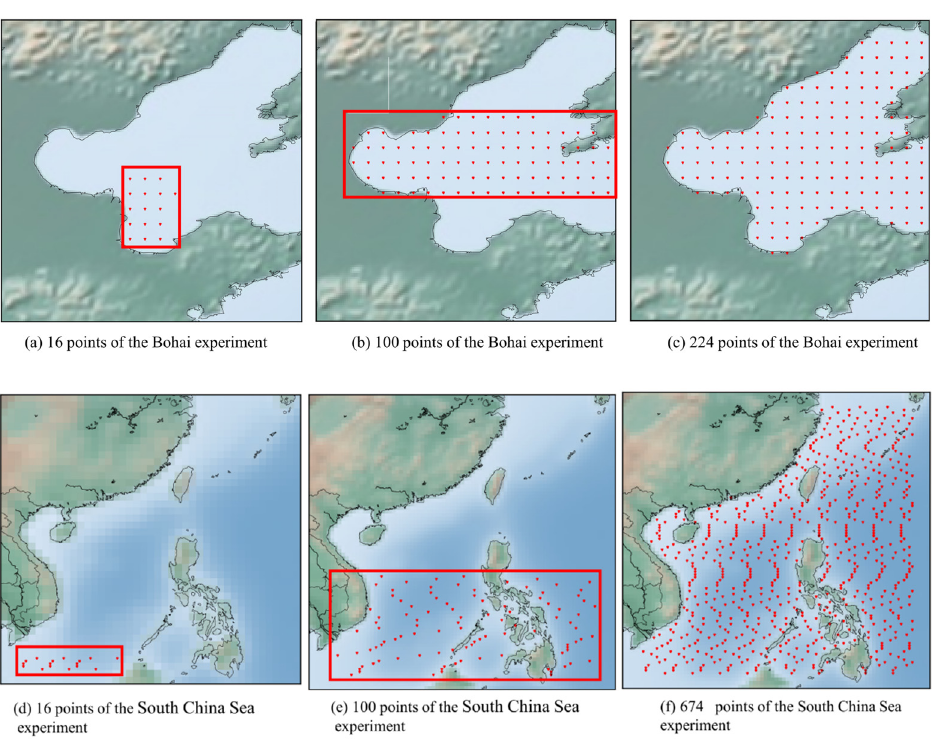
Figure 3. Location maps of the experiment. The red dots indicate the predicted points. ( a – c ) represent the predicted areas at 16, 100 and 224 points in the Bohai Sea. ( d – f ) represent the predicted areas at 16, 100 and 674 points in the South China Sea.